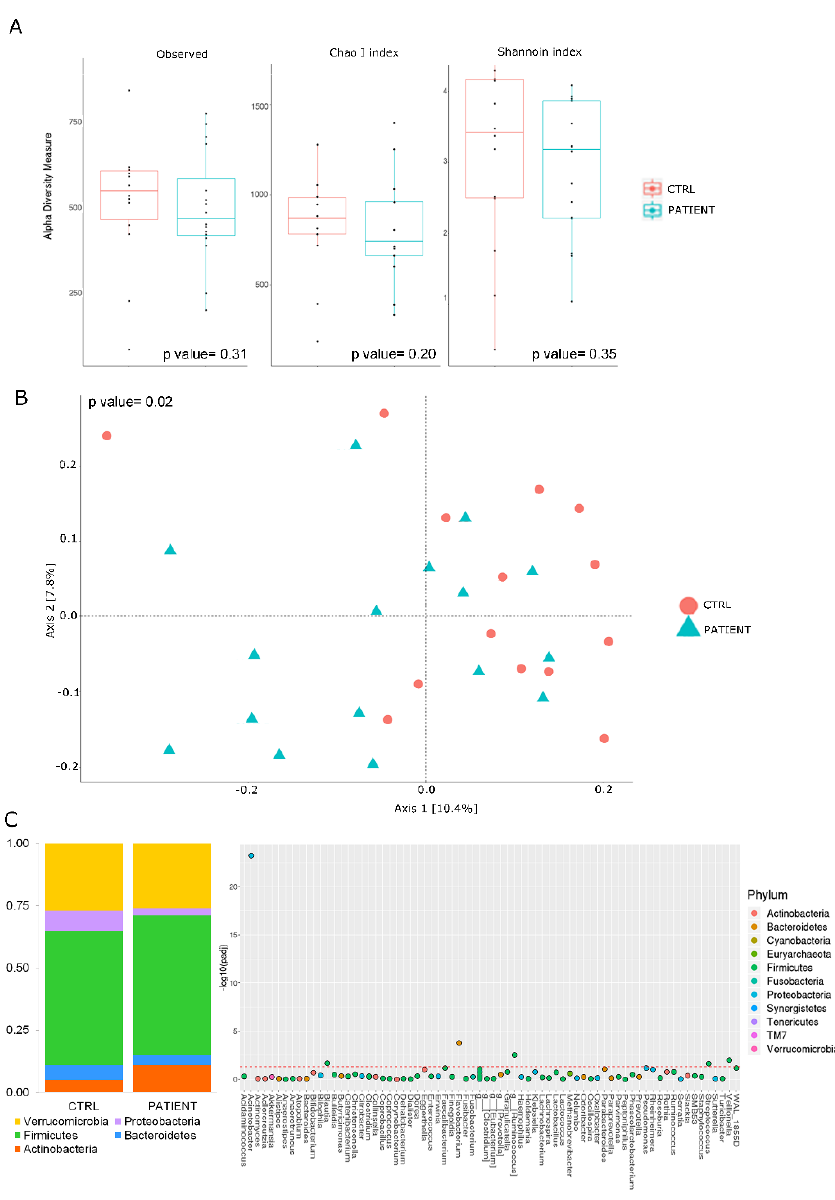
Figure 5. Gut microbiota alteration in RC patient (cohort I). ( A ) Boxplots representing α -diversity indices. The interquartile range is represented by the box and the line in the box is the median. The whiskers indicate the largest and the lowest data points, respectively, while the dots symbolize samples. The analysis of the gut microbiota showed a certain degree of reduction in the observed species and of the CHAO 1 and of Shannon indexes between the two groups. Furthermore, a greater degree of reduction in biodiversity seems more evident in the group of patients (cohort I) versus controls (cohort II). ( B ) β diversity analysis performed by Bray Curtis distance matrix and plotted by PCoA plot. Patients affected by RC (green, PTS, cohort I) tend to cluster differently than controls (red, ctr, cohort I). PERMANOVA p value = 0.02. ( C ) Phylum distribution (left side) and species distribution between RC patients (cohort I) and controls (cohort II) (right side). Firmicutes and Verrucomicrobia were the most represented phylum of gut microbiota (left side). In terms of prevalent microbial species, some species seem more abundant than others species. In the controls, particular abundance was found for Acinetobacter , while the most candidate species as potential markers of dysbiosis in the course of recurrent cystitis seem to belong above all to the phylum of Firmicutes , such as Ruminococcus , Blautia , Veillonella , Streptococcus spp. Mann–Whitney U test p values ≤ 0.05 (right